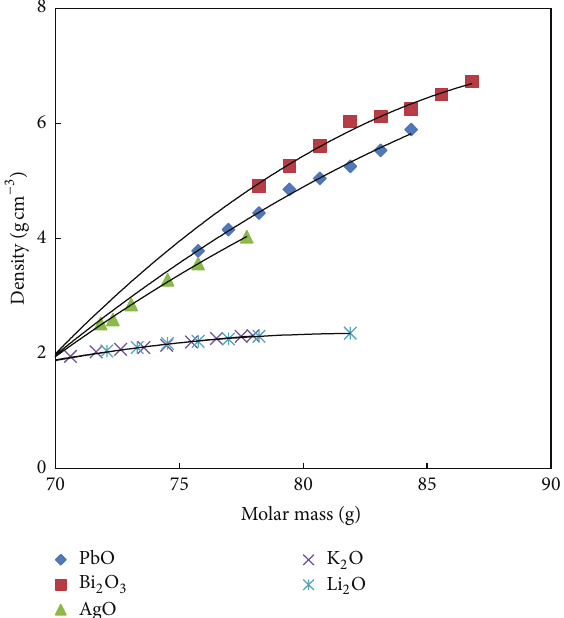
Figure 2: Changes in density ( 𝜌 ) of binary borate glasses as a function of modifier oxide concentrations of Pb and Bi oxides with those of Ag, K, and Li molar masses ( 𝑀 ) [22,